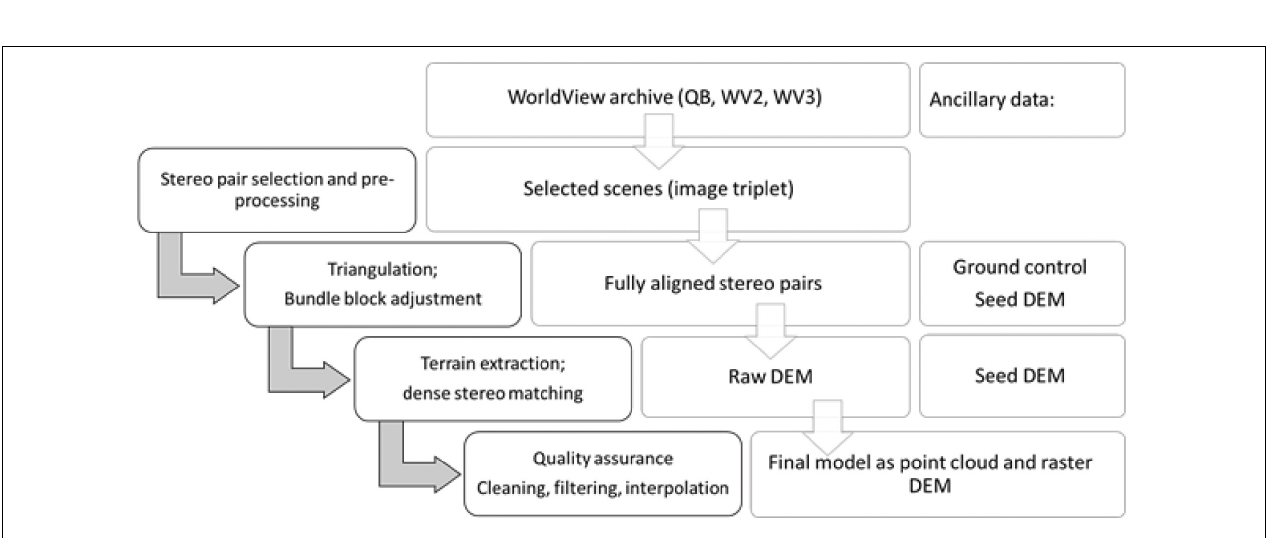
FIGURE 6 | Generalized spaceborne photogrammetric